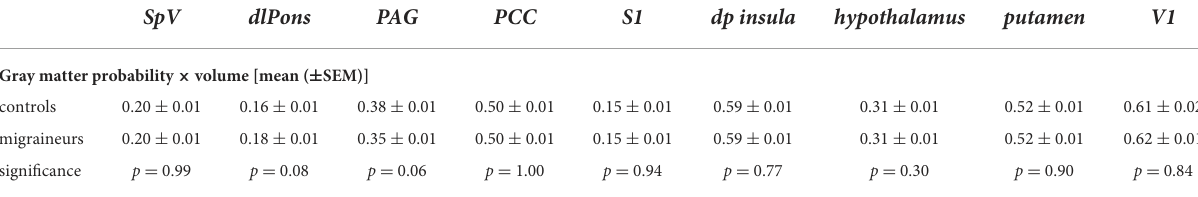
TABLE 4 Gray matter probability × volume and p- values for significant brainstem and wholebrain MD derived clusters in migraineurs and controls (corrected for multiple